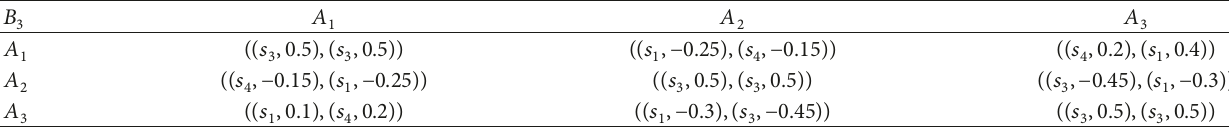
Table 5: I2TLPR of alternatives concerning the criterion 𝐶 3